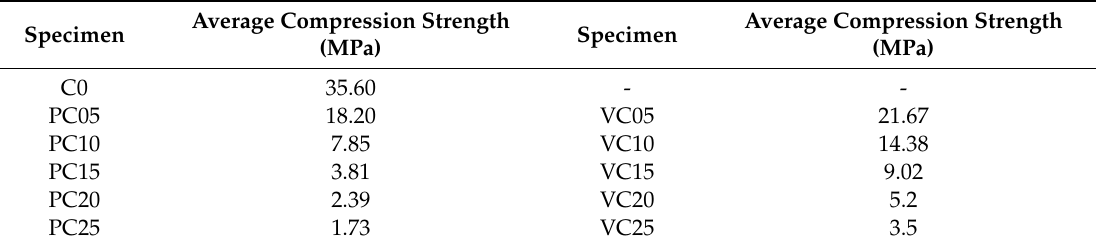
Table 3. The average 3-day compressive strength of the classfied specimens.